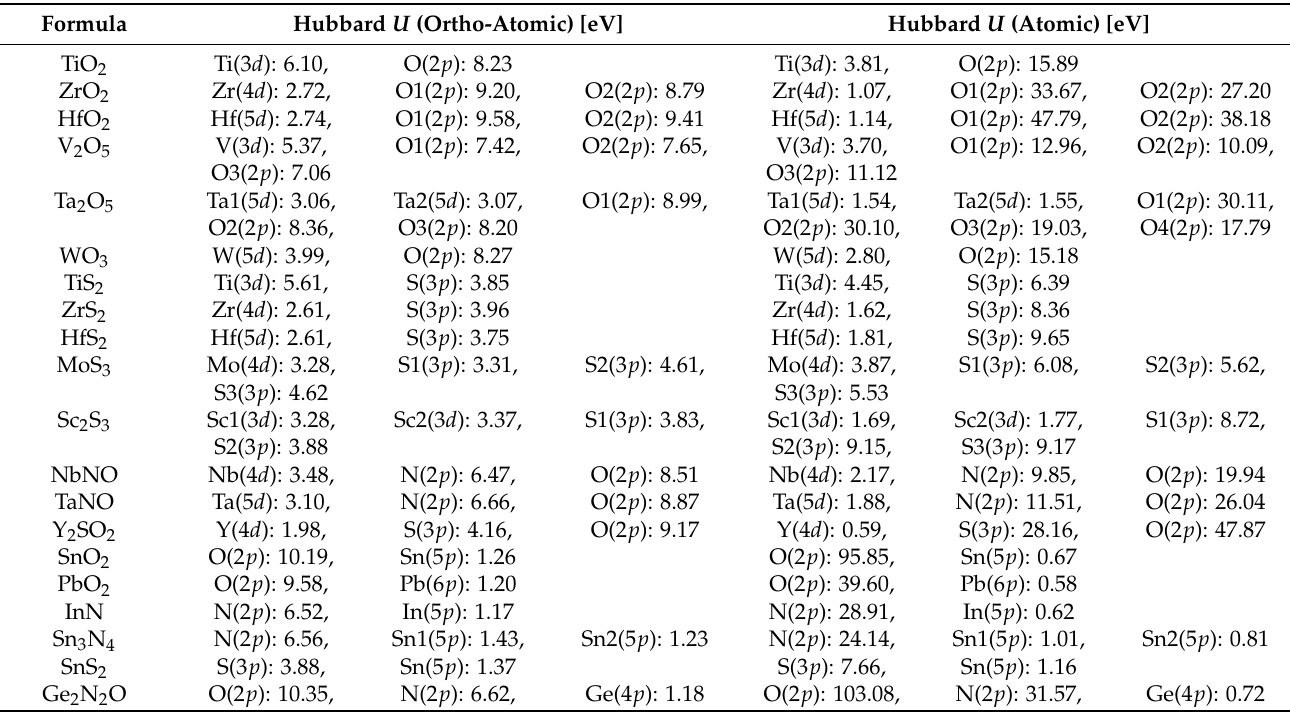
Table 2. Comparison of the Hubbard U parameters (in eV) as computed using DFPT with atomic and ortho-atomic Hubbard projectors. Numbered atoms (e.g., O1, O2) indicate nonequivalent atoms which require individual U values. Formula Hubbard U (Ortho-Atomic) [eV]